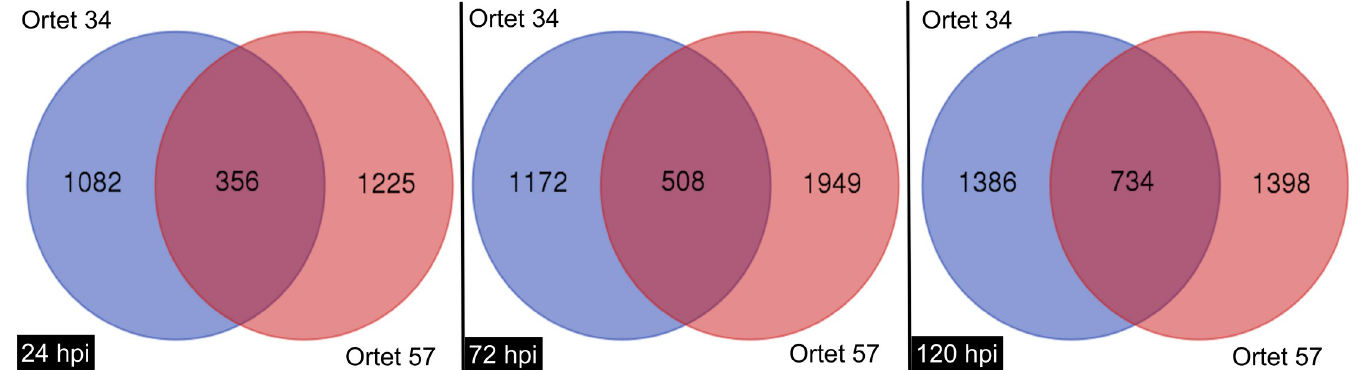
Fig 2. Venn diagram for unigenes expressing differentially in contrasting ortets. A. 24 hpi; B. 72 hpi; C. 120 hpi. Ortet 57: susceptible. Ortet 34: Resistant.